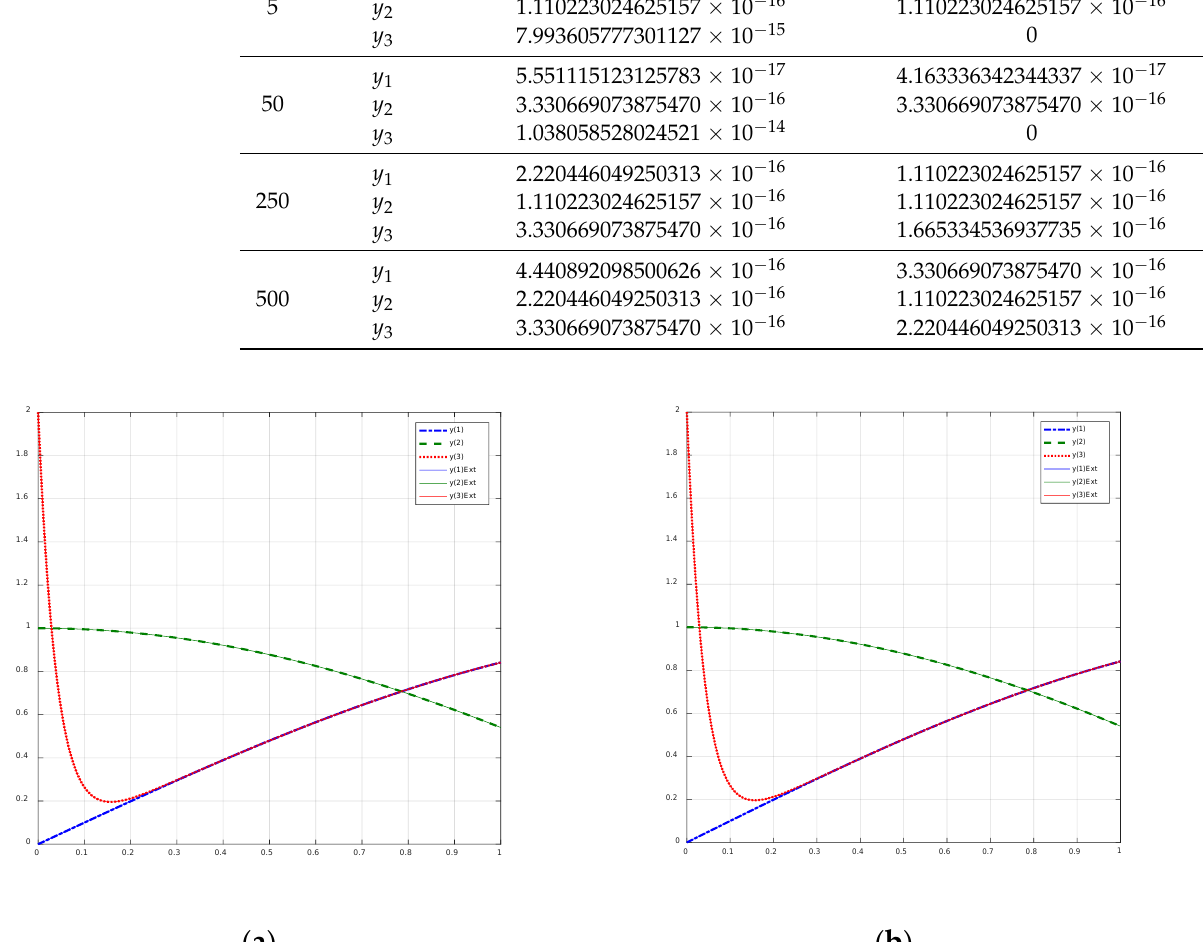
Figure 4. Graphical plots of Example 2 using block hybrid methods with nfe = 500. ( a ) Solution curve of Example 2 using (18); ( b ) solution curve of Example 2 using (21).